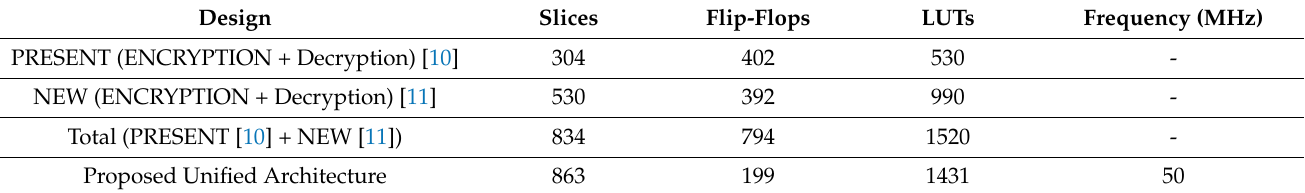
Table 8. Synthesis results for the proposed unified encryption/decryption hardware architecture.